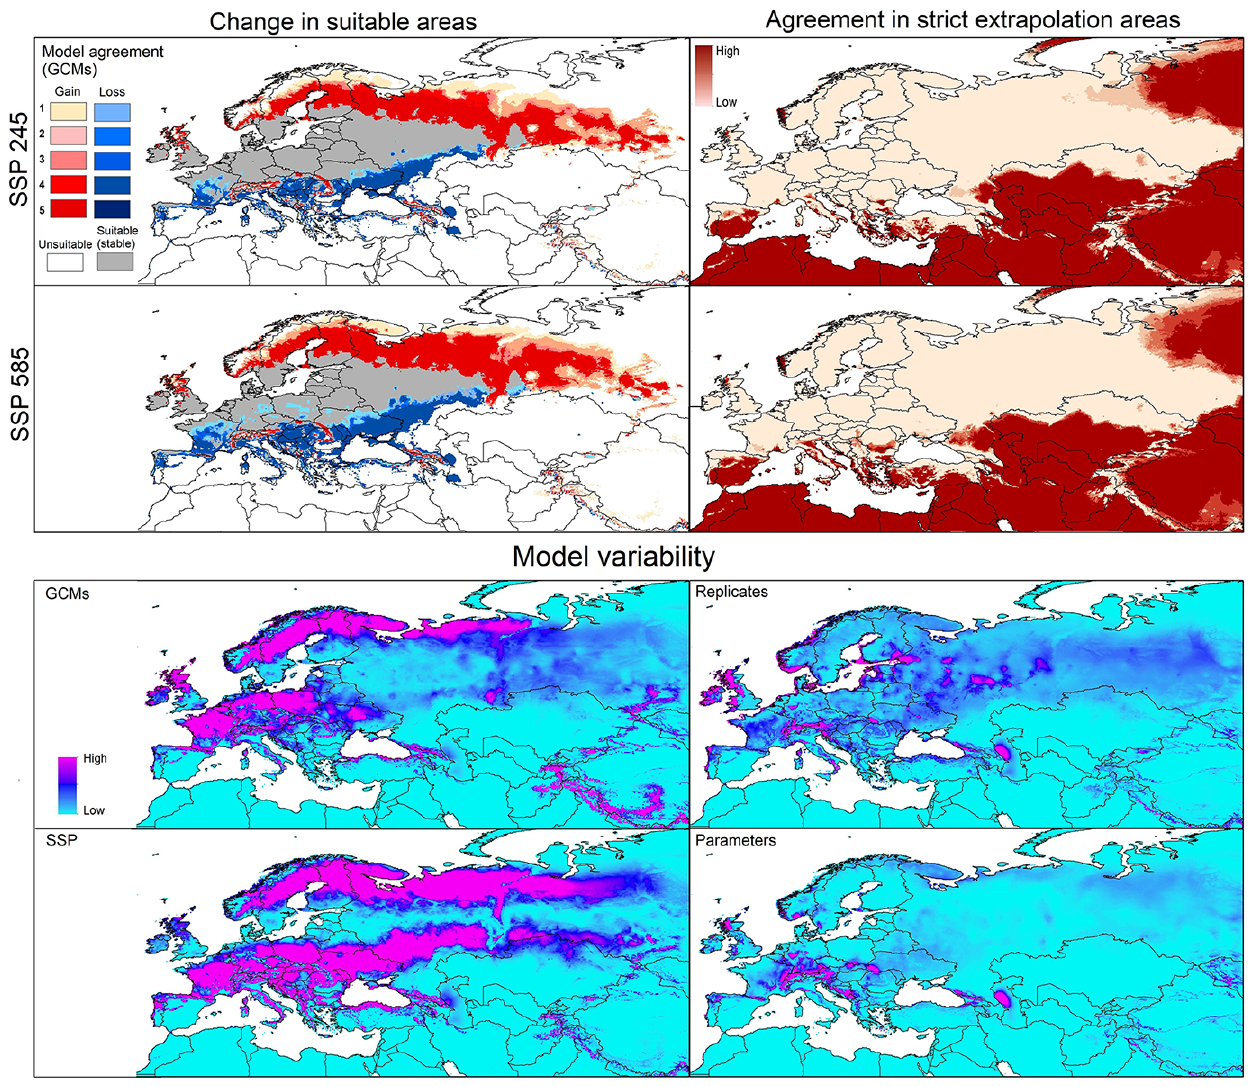
Figure 3. Left panels: potential geographic distribution of Dermacentor reticulatus based on current (in blue and gray) and future (blue denotes no longer suitable; red denotes newly suitable) conditions. Right panels: agreement in strict extrapolation areas among the five general circulation models. Model variability: median of variance coming from GCMs, replicates, SSP, and parameters in future